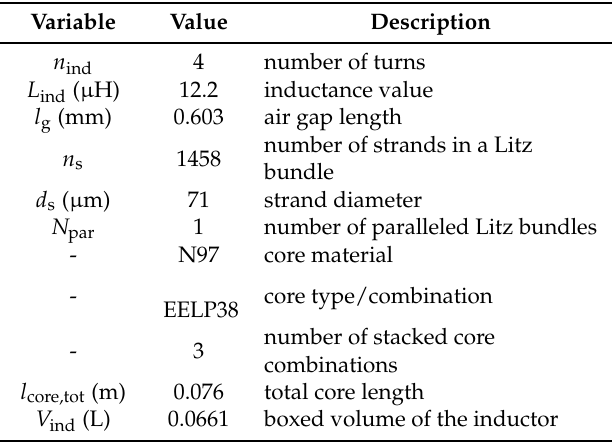
Table A7. Design values for the external series inductor L ext